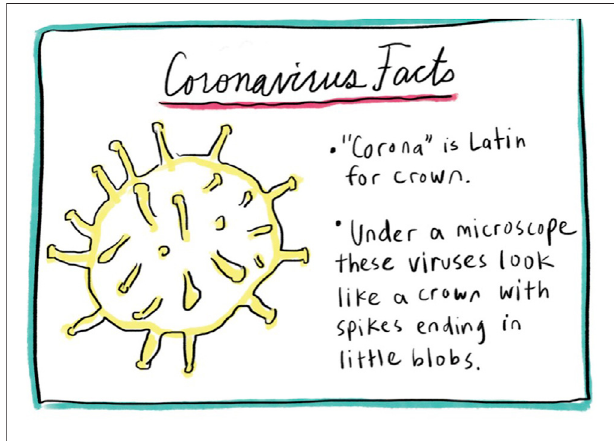
FIGURE 1 | Coronavirus facts (Gharib & Turner,